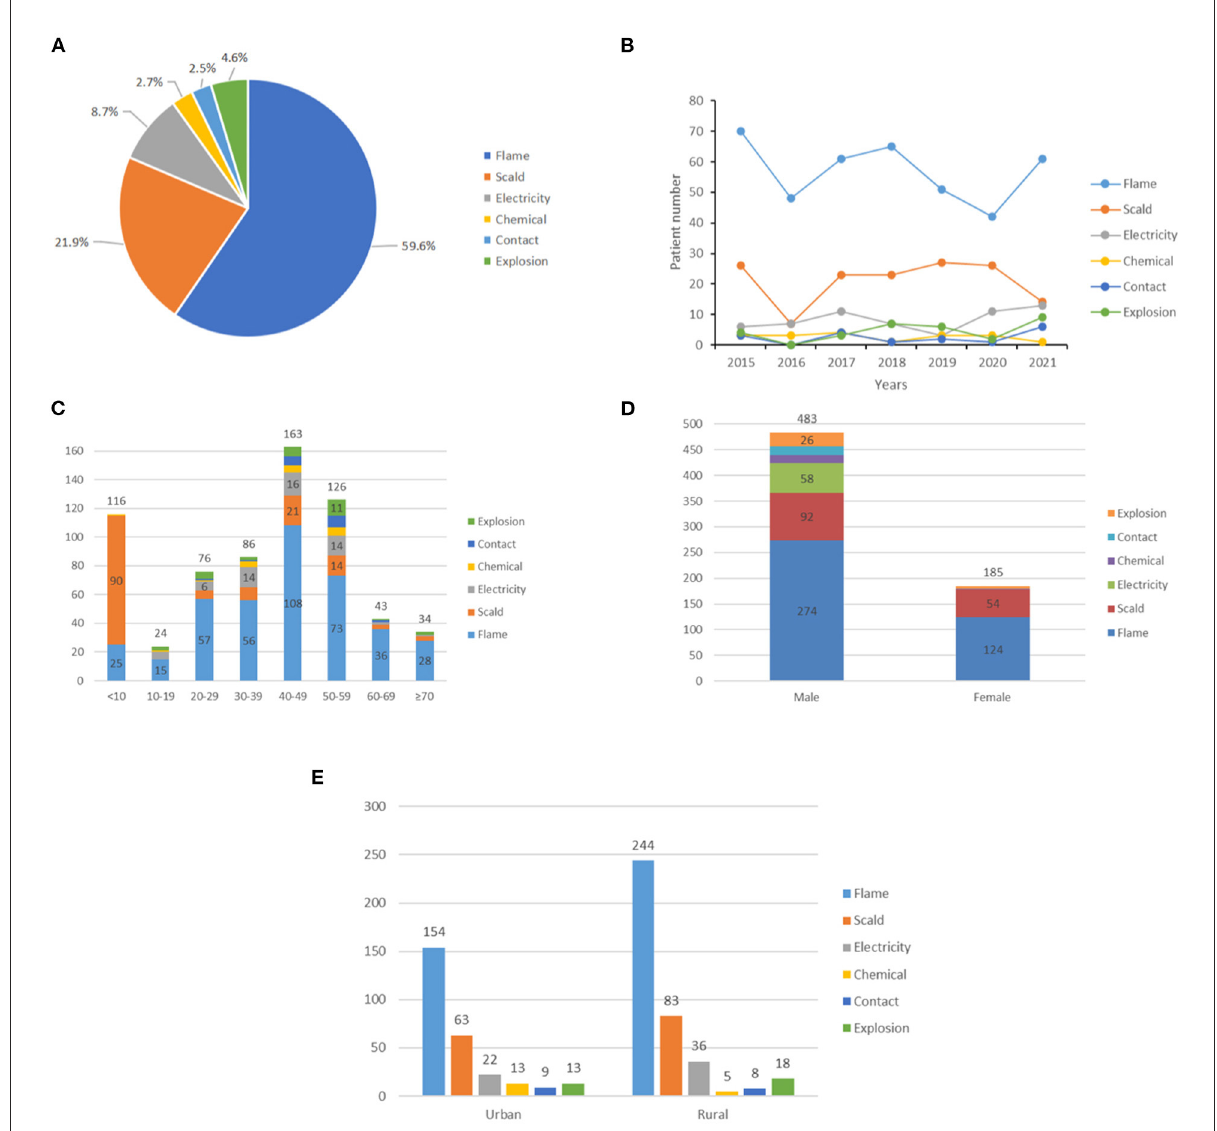
FIGURE2 Etiological analysis. (A) Distribution of burn type. (B) Distribution of etiology by year. (C) Distribution of etiology by age. (D) Distribution of etiology by gender. (E) Distribution of etiology by